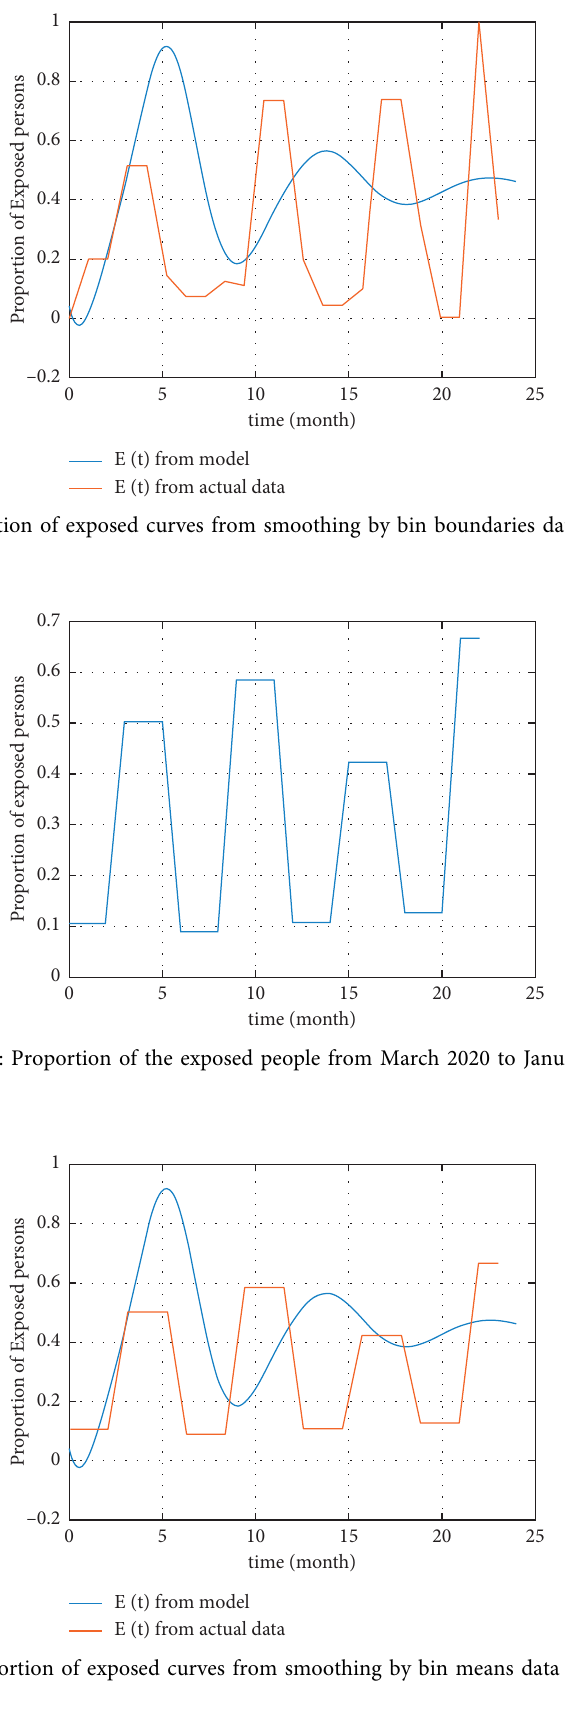
Figure 20: Proportion of exposed curves from smoothing by bin means data and the